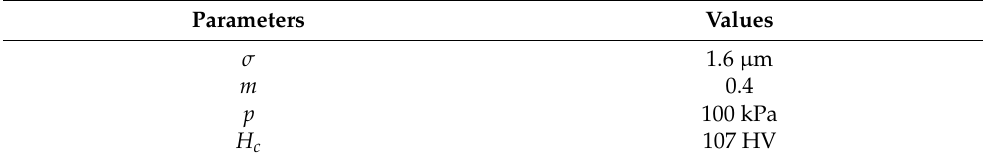
Table 2. Defined values of parameters. Parameters Values